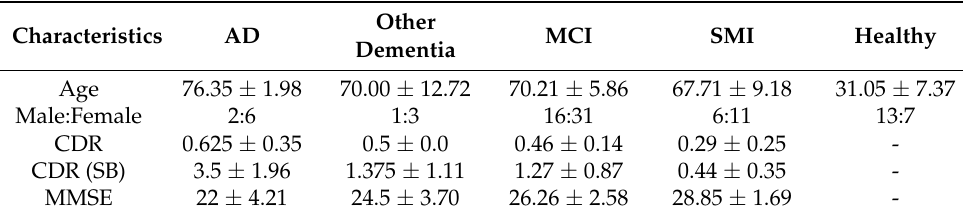
Table 1. The demographic information of patients (age, clinical dementia rating (CDR), CDR (SB), and MMSE-mini-mental status examination shown as mean ± standard deviation). Other Characteristics AD Dementia